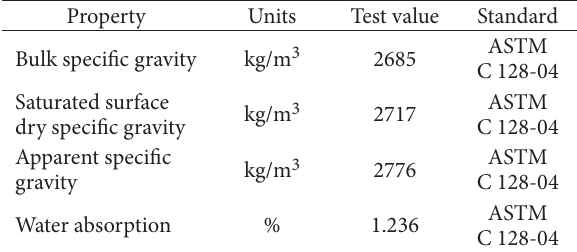
Table 3. Physical properties of fine